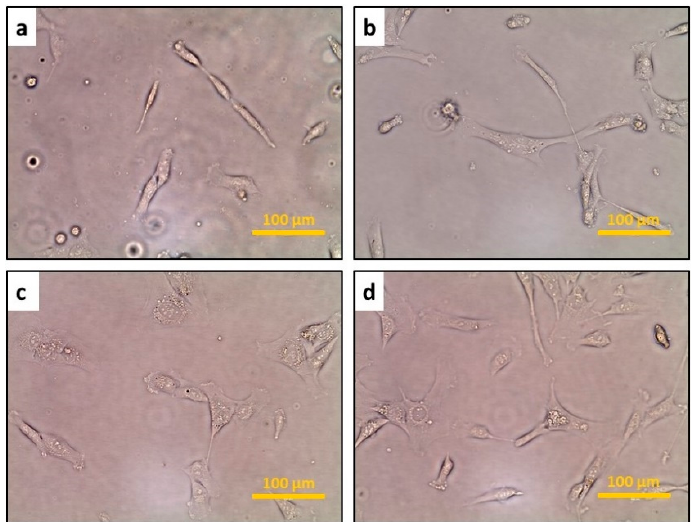
Figure 1. Confluence of human fetal osteoblast (hFOB) 1.19 cells cultured in complete growth media at different time points:( a ) 20%–30% of cell confluence at 24 h; ( b ) 30%–40% of cell confluence at 48 h; ( c ) 50%–60% of cell confluence at 72 h; and ( d ) 70%–90% of cell confluence at 96 h of seeding.